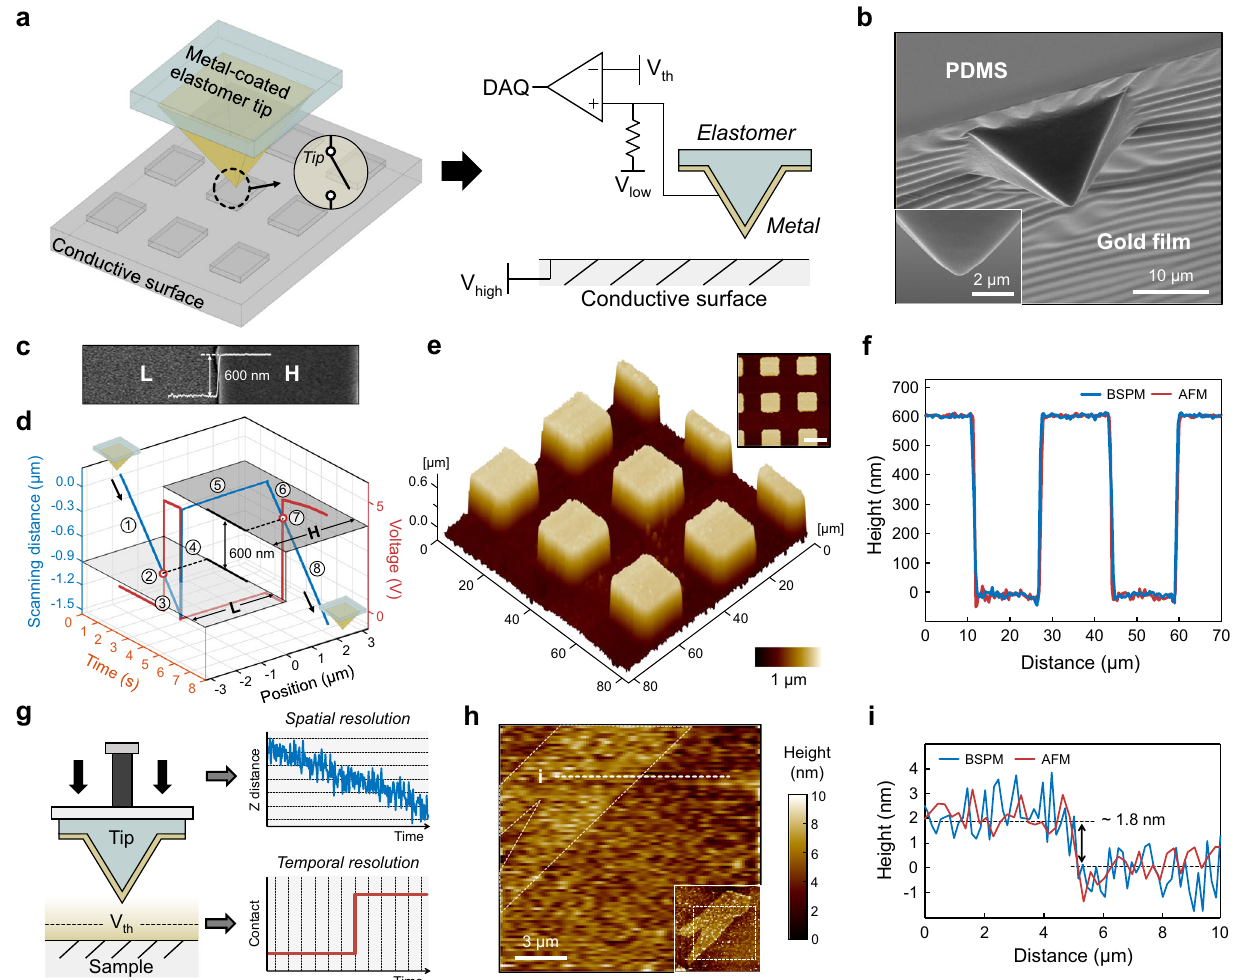
Fig. 2 Implementation of BSPM. a Schematic illustration depicting the function of the metal-coated elastomer tip. b Scanning electron microscopy (SEM) image of the metal-coated elastomer tip. The inset shows the magni fi ed image of the apex of a tip (scale bar: 2 μ m). c SEM image and line pro fi le of the test sample for the point measurement. d Raw data of the point measurement. The red and blue axes show the voltage of the tip and the scanning distance of the piezo actuator, respectively. The circled number indicates the corresponding situation of the tip depicted in Supplementary Fig. 3. Topography image ( e ) and line pro fi le ( f ) of the 16 × 16- μ m 2 square patterns with a thickness of 600 nm measured by BSPM. The inset in e shows the 2D mapping of the topography (scale bar: 20 μ m). g Conceptual illustration showing the spatial resolution of the piezo actuator and the temporal resolution of the tip. h Topography of the multilayer graphene sheet measured by BSPM. The inset shows the same region measured by AFM. i Line pro fi les of the multilayer graphene sheet indicated in h